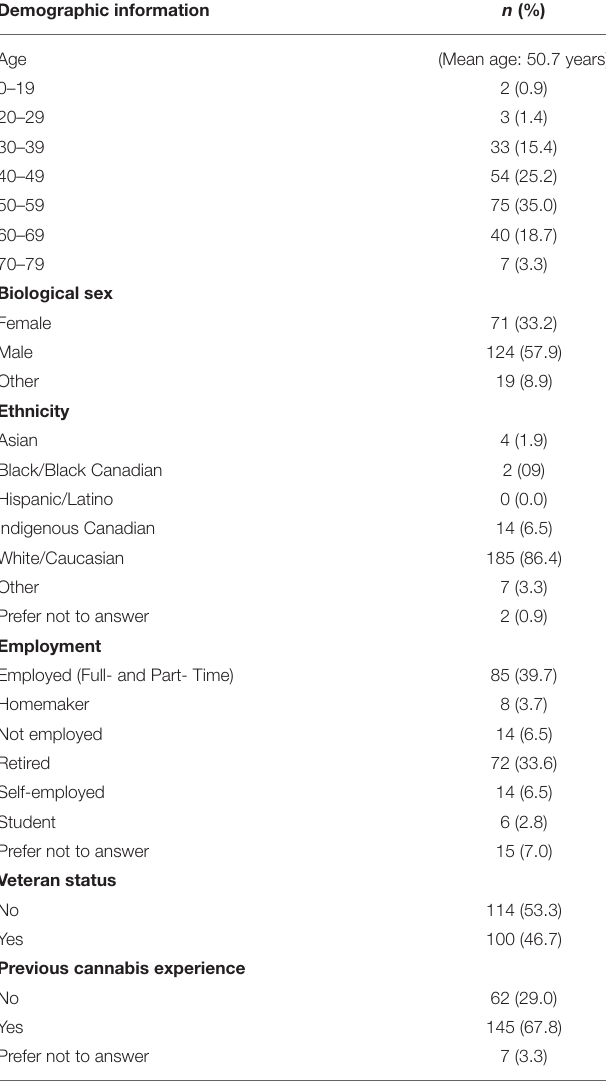
TABLE 2 | Information related to recurring pain for the medical cannabis patient